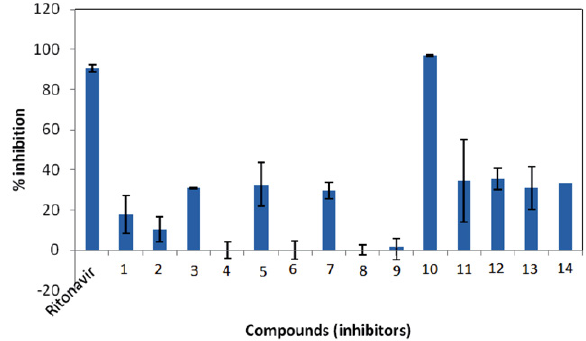
Figure 6. HIV-1 protease screening results illustrating percentage inhibition of selected diamine derivatives of benzoyl isothiocyanate (100 μM) and ritonavir (10 μM) relative to untreated control. Error bars represent standard deviation of n =